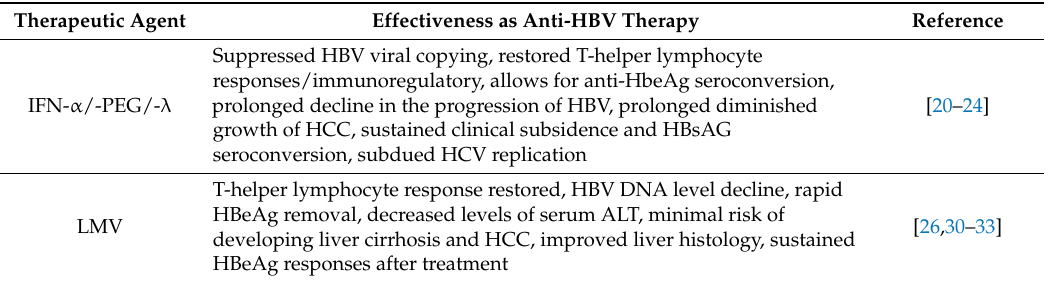
Table 1. Summary of anti-hepatitis B virus (HBV) cytokine and nucleot(s)ide analogue therapeutic agents as a treatment